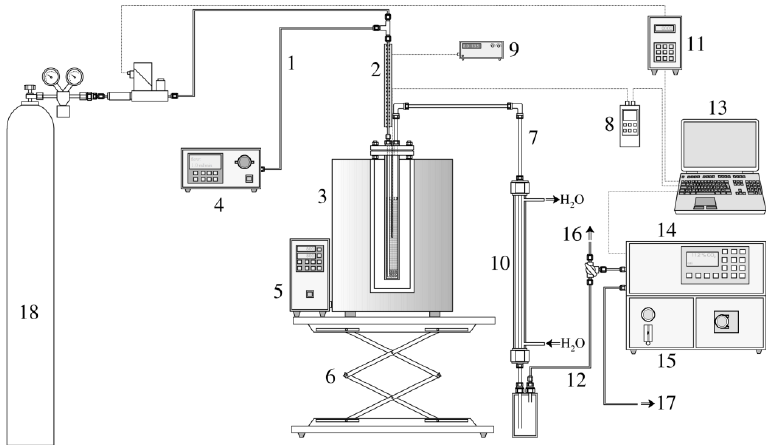
Figure A2. The activation apparatus (1—inlet water capillary, 2—inlet preheating, 3—furnace, 4— water dosing pump, 5—furnace controller, 6—furnace scissor lift, 7—reactor output pipe, 8—ther- mometer/datalogger, 9—preheating controller, 10—water cooler, 11—programming unit of the gas flow meter/controller, 12—gas output to the analyzer, 13—PC for data recording, 14—gas analyzer, 15—chilling and filtering unit of the analyzer, 16—excess gas flow valve, 17—gas output, and 18— pressure cylinder containing N 2 ).